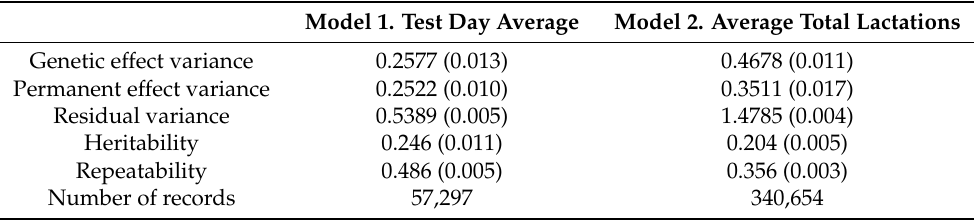
Table 2. Estimates of variance components and genetic parameters for average somatic cell score according to the univariate model.